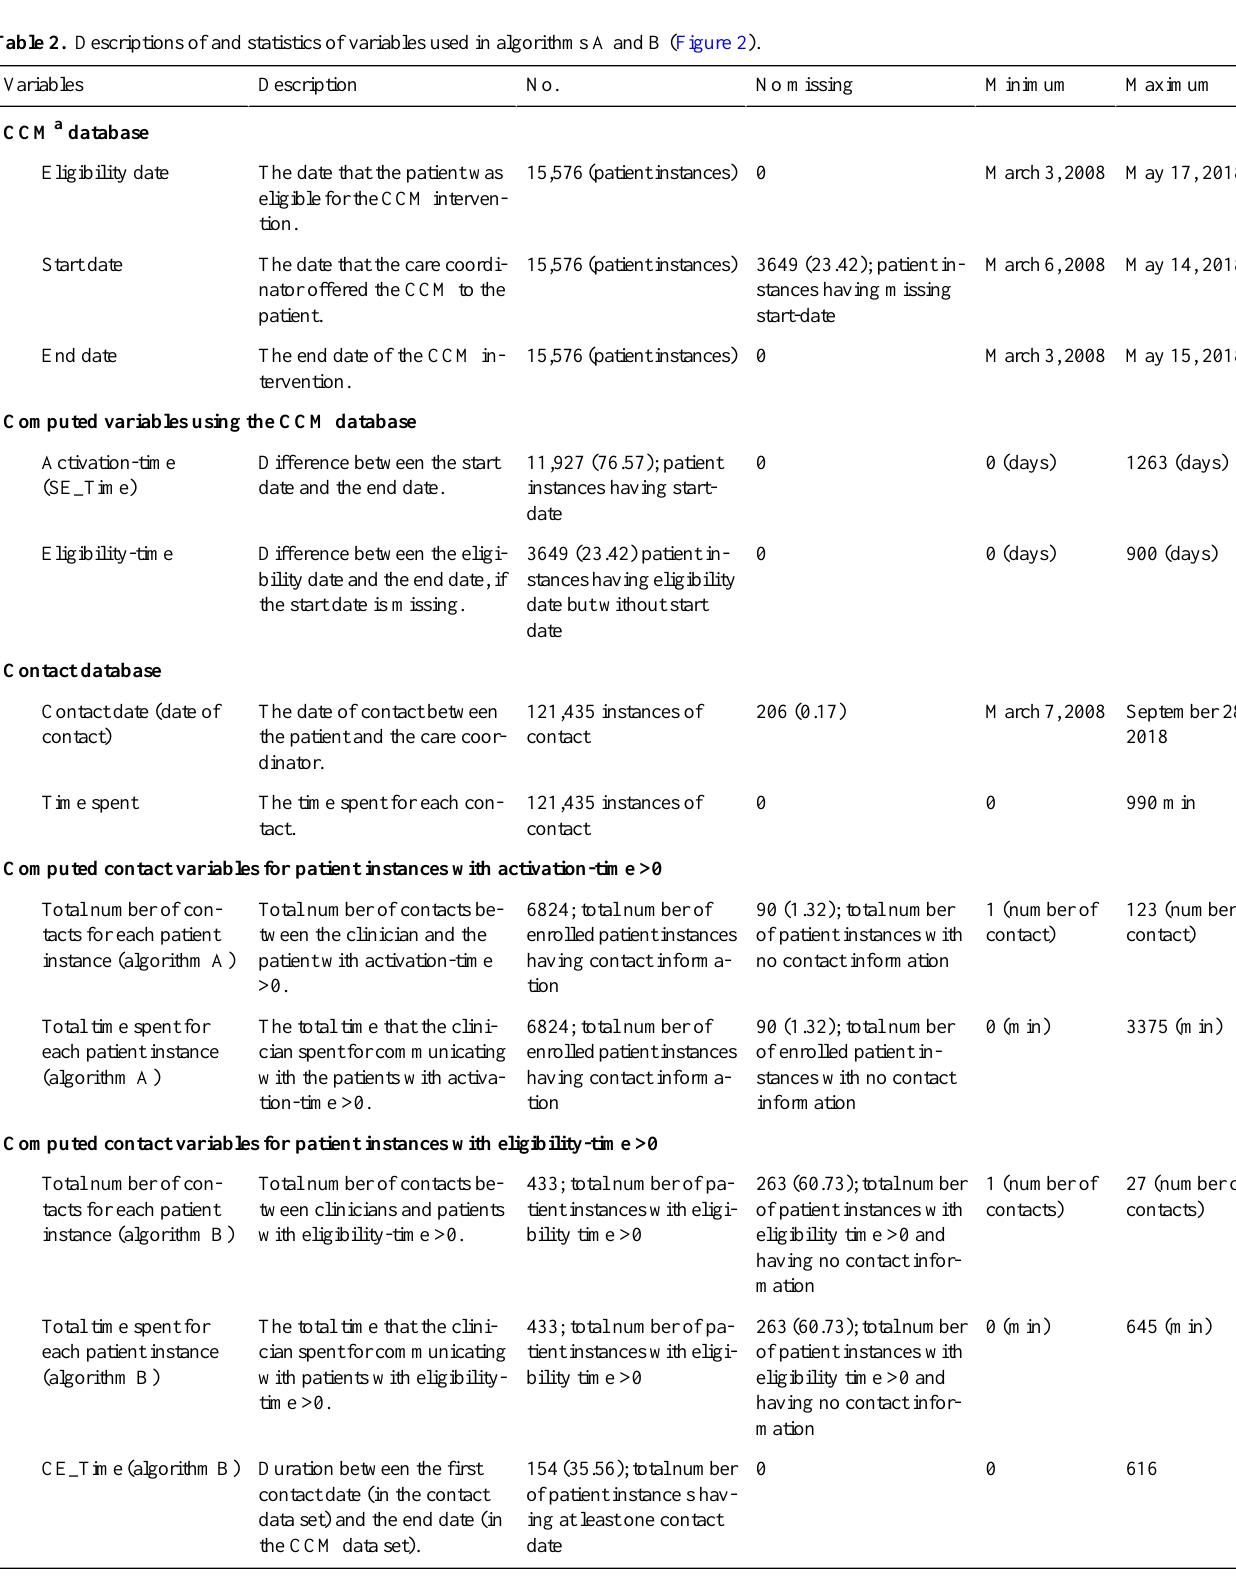
Table 2. Descriptions of and statistics of variables used in algorithms A and B (Figure 2).